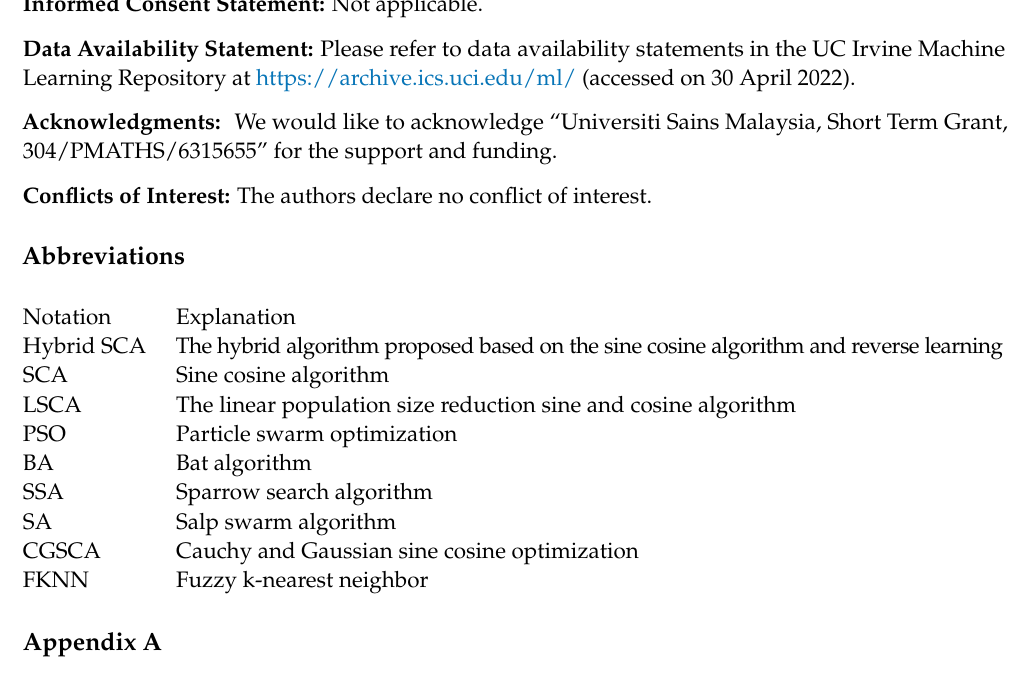
Table A1. Numerical results for three two-class datasets in different MaxFEs when K = 5-fold